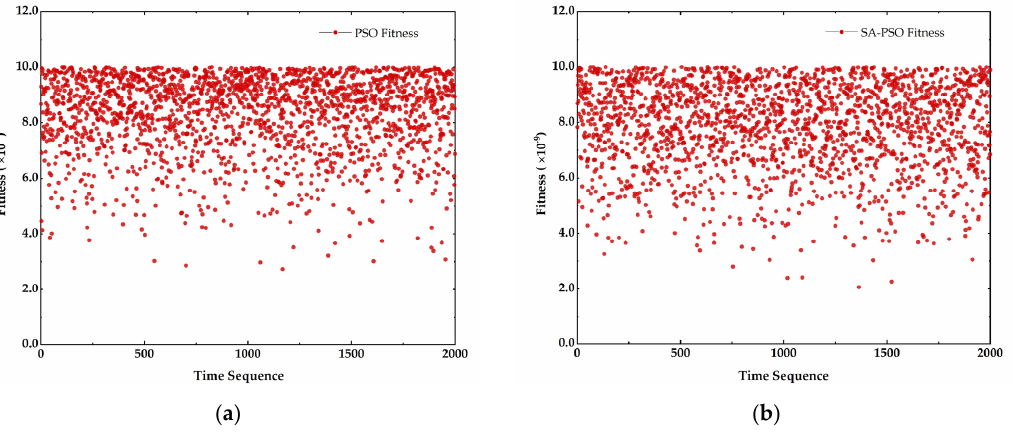
Figure 7. The fitness for the continuous trajectory. ( a ) Fitness of PSO. ( b ) Fitness of SA–PSO.